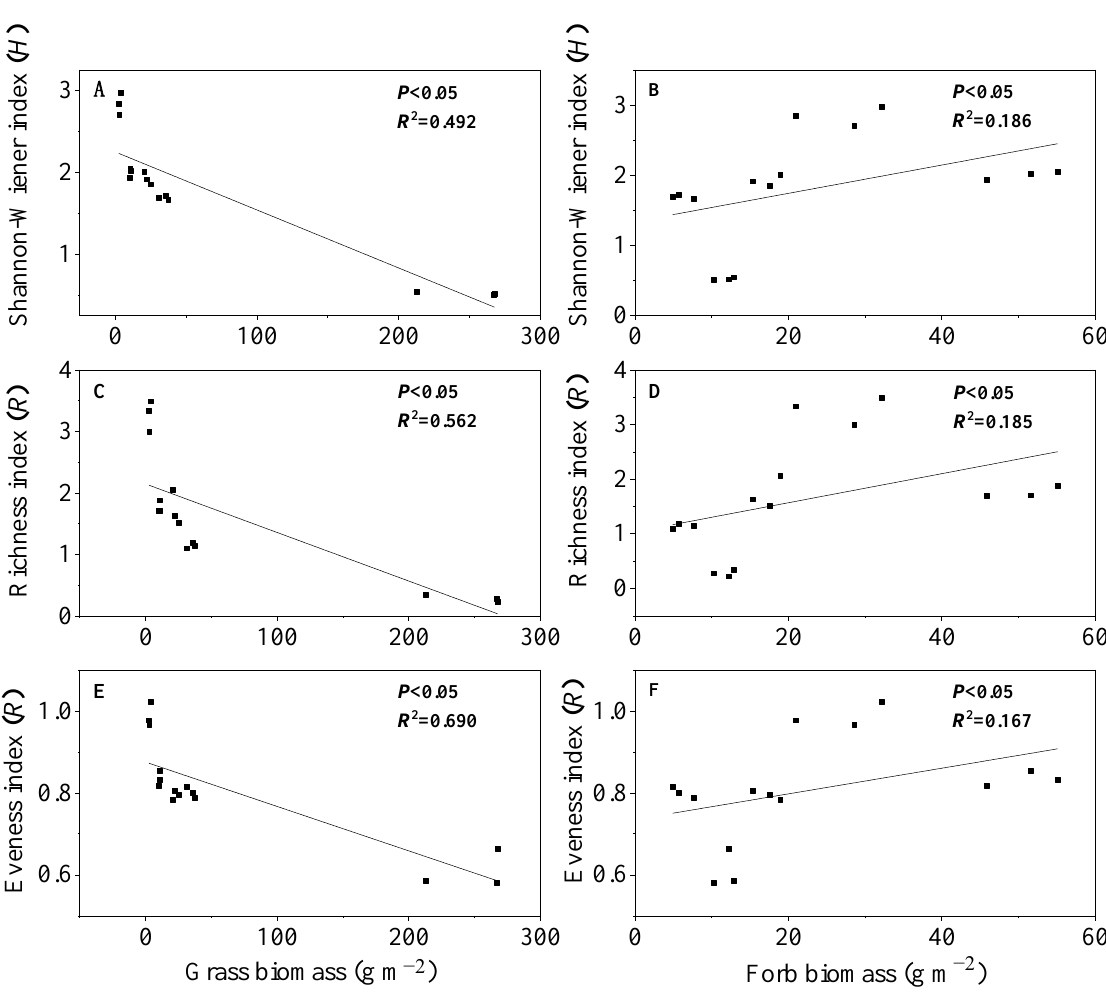
Figure 5. Linear regressions of biomasses of two functional groups (grasses and forbs) and plant diversity (Shannon–Wiener index, Richness index, and Evenness index). ( A , C , E ), linear regressions between grass biomass and indices of diversity, richness and evenness, respectively; ( B , D , F ), linear regressions between forb biomass and indices of diversity, richness and evenness, respectively. Lines represent significant regressions model at p < 0.05 level.